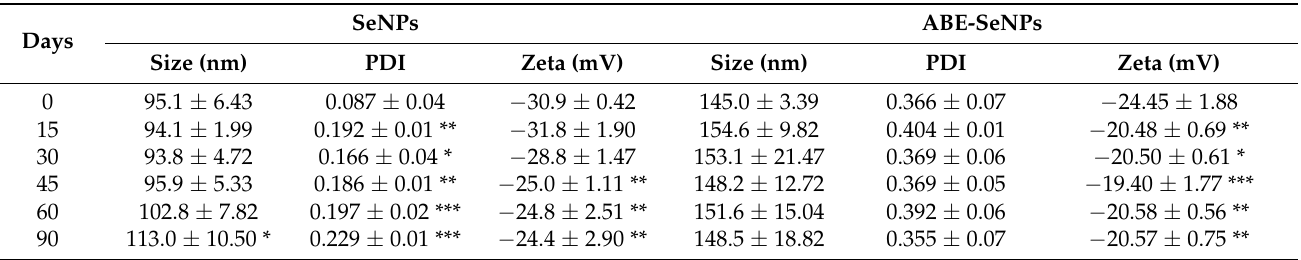
Table 1. Size, PDI, and zeta potential of SeNPs and ABE-SeNPs after various 4 ◦ C storage